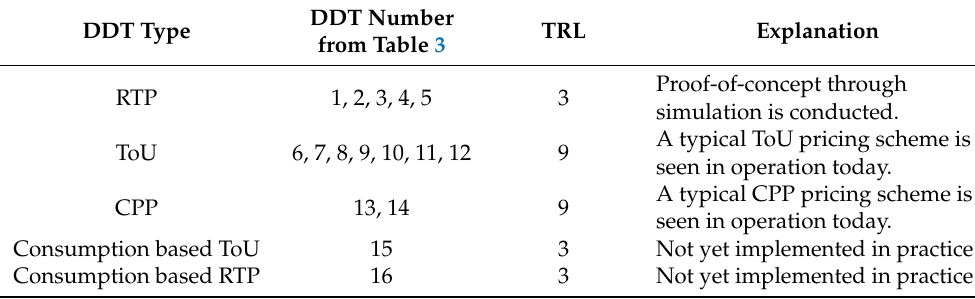
Table 6. Technology readiness level of identified